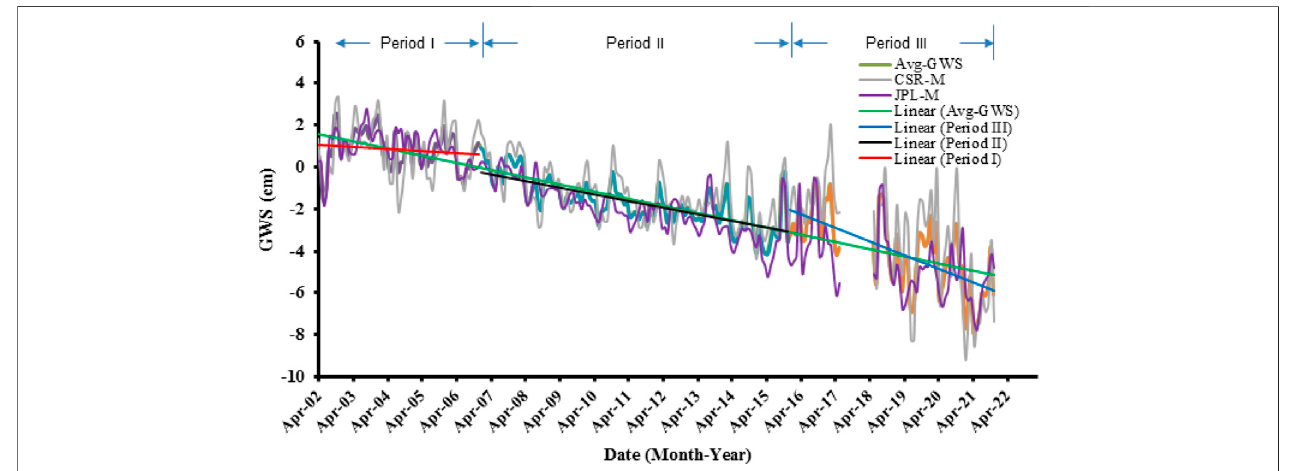
Frontiers in Earth Science |